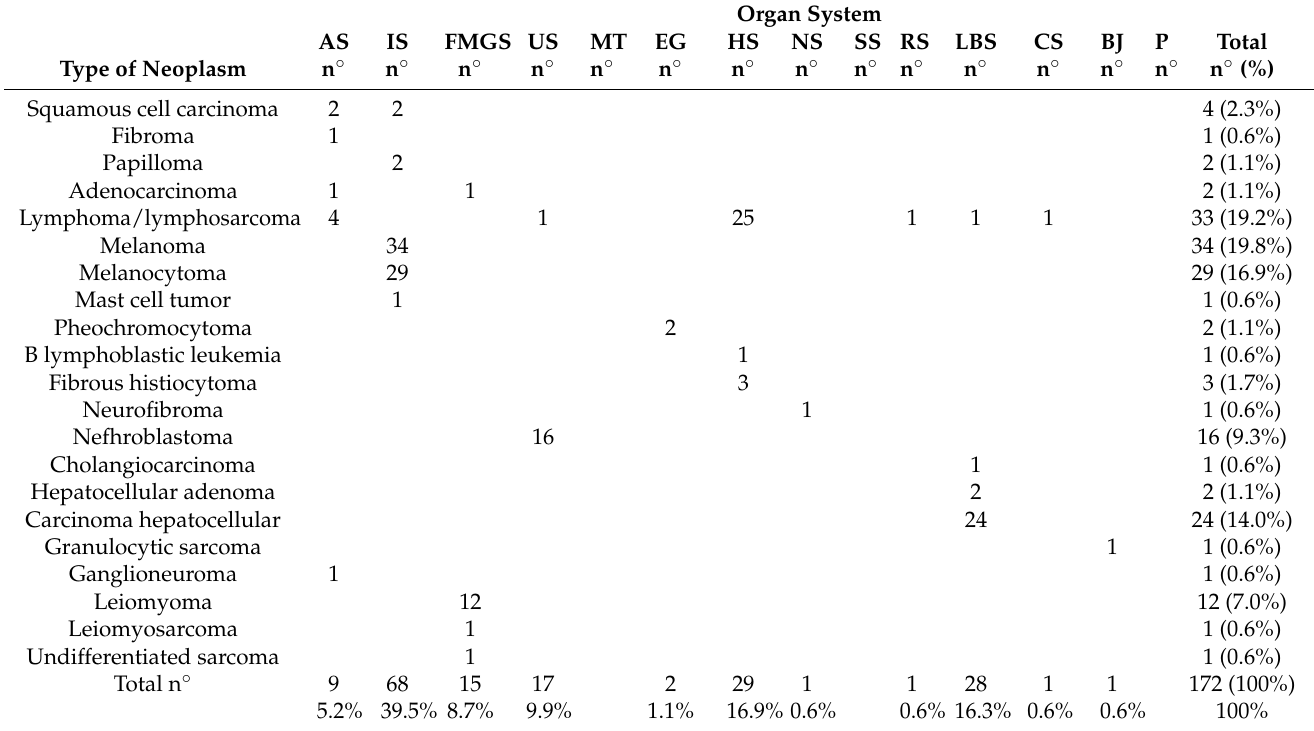
Table 7. Distribution of neoplasms in swine according to the organ system. Organ